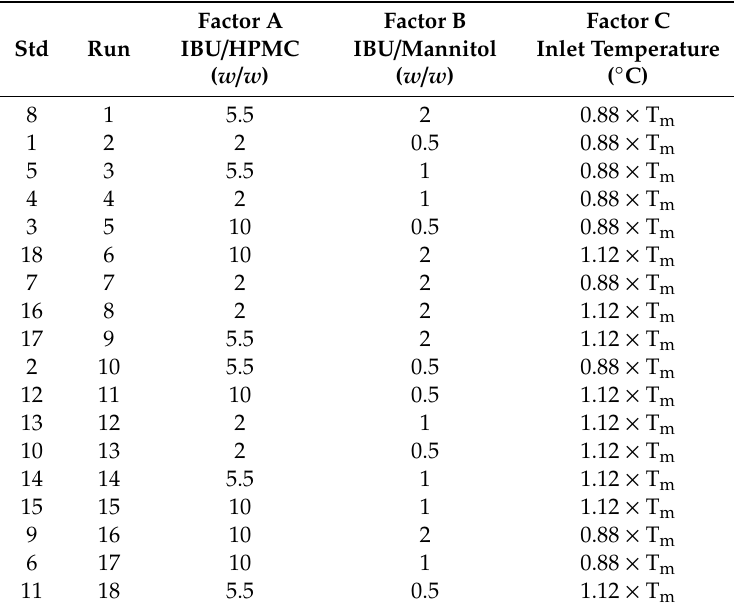
Table 1. DoE for the WMM and SD of IBU, using Pharmacoat 603 as stabilizer and mannitol as a co-milling agent. Factor A Std Run IBU /